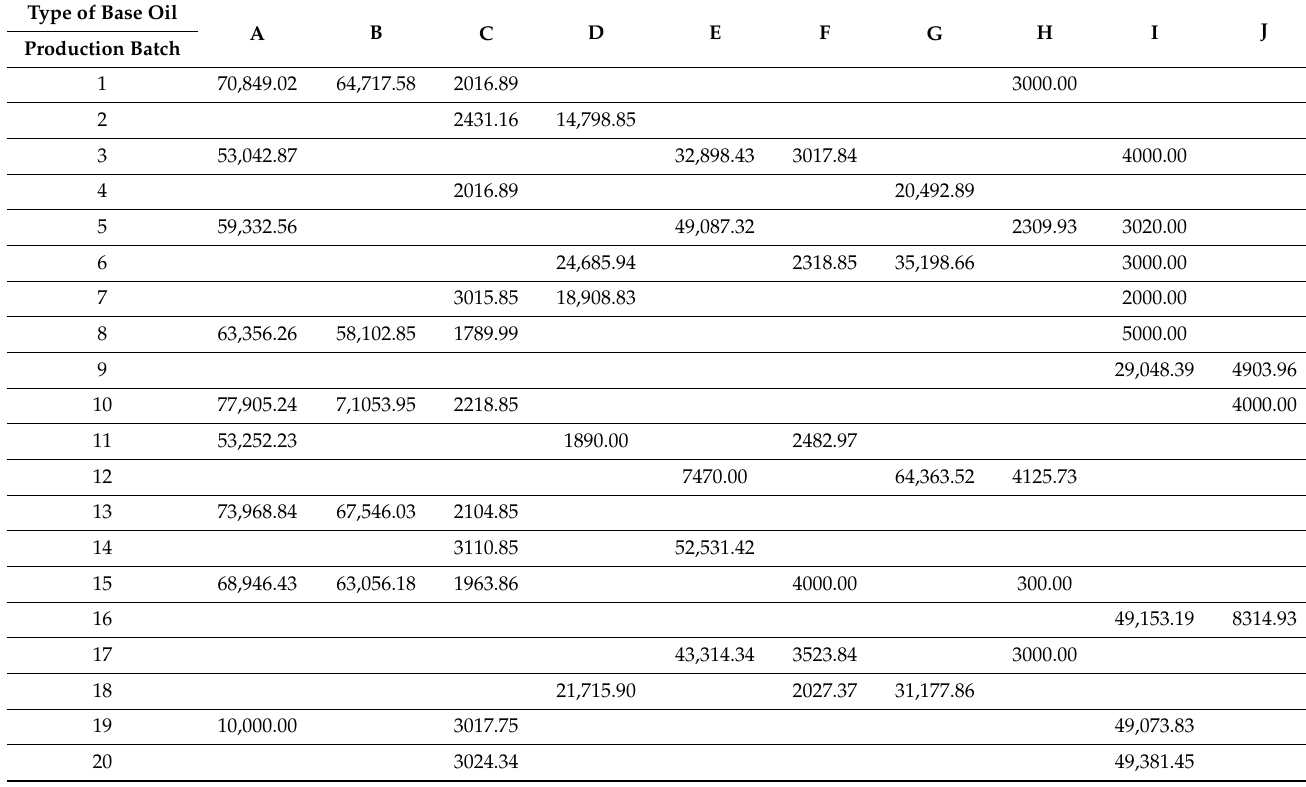
Table 2. Production data of each batch of blended oil (unit: